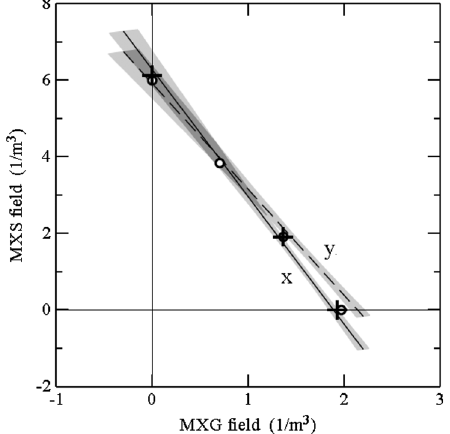
FIG. 22. Two lines with error bands show the places where the x and y chromaticities were consistent with zero. The locations of the points of largest IPP lifetime are shown by the circles for the wide beam and the plus signs for the long beam. For the long beam, the point from Scan 4 is missing.